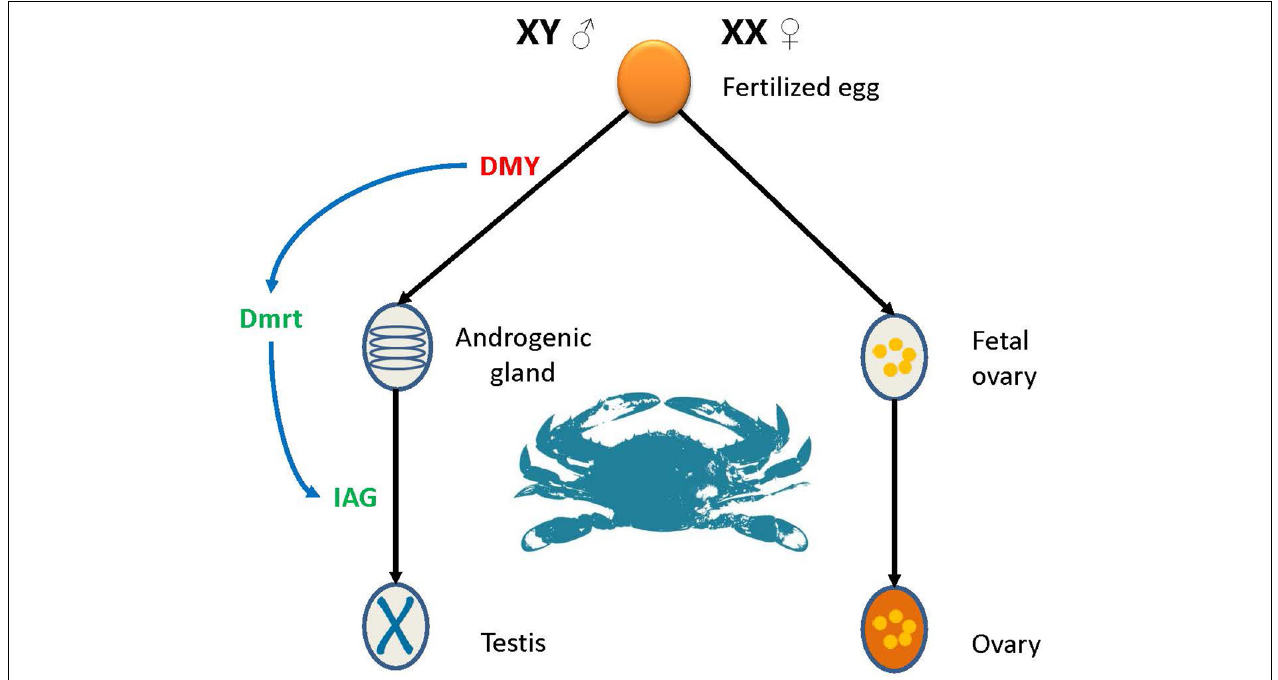
FIGURE 9 | Pattern of sex determination in P.